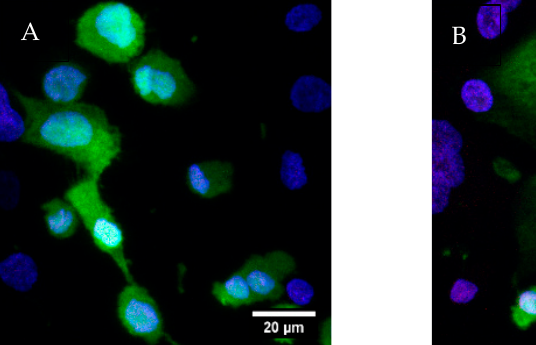
Figure 3. Confocal microscopy images of cellular uptake and distribution of ATRA-Rhodamine co- loaded PLGA NPs treatment for 24h. THP-1 differentiated macrophages were treated with ( A ) RPMI, ( B ) blank PLGA NPs, and ( C ) ATRA-Rhodamine co-loaded PLGA NPs (red) and viewed 24 h later using confocal microscopy (Carl Zeiss, Jena, Germany) at 40×. Hoechst (blue) stains nuclei, HCS CellMask™ Green (green) stains cytoplasm. Scale bar: 20 μ m.